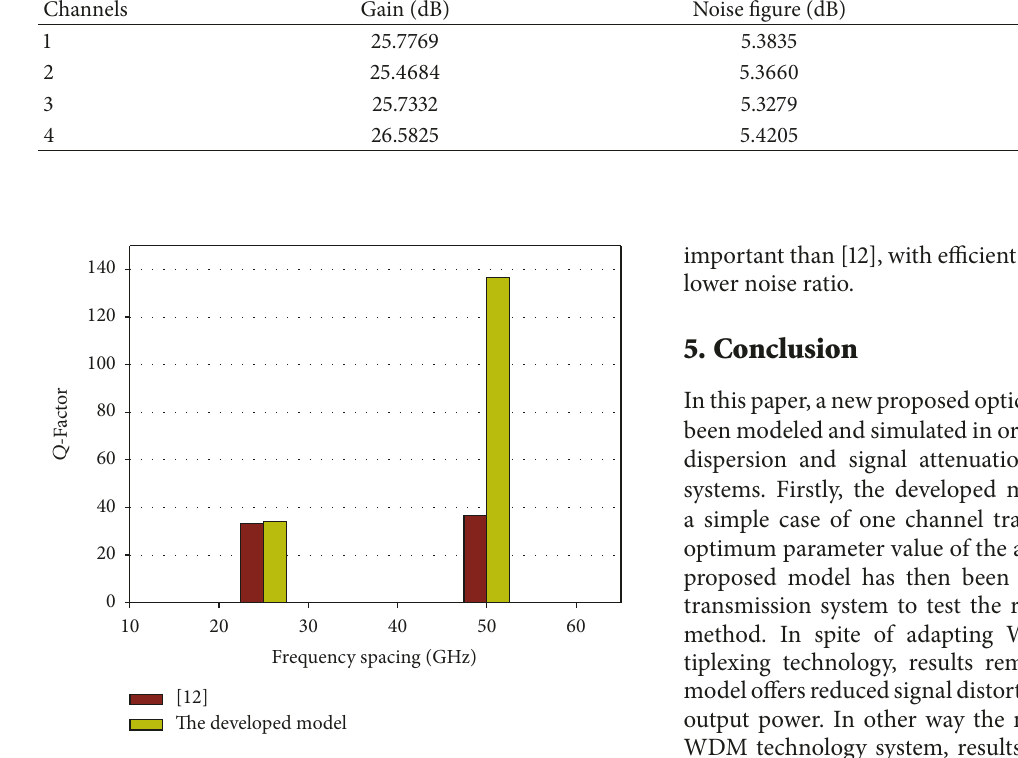
Figure 12: Comparison parameters with a previous model and our